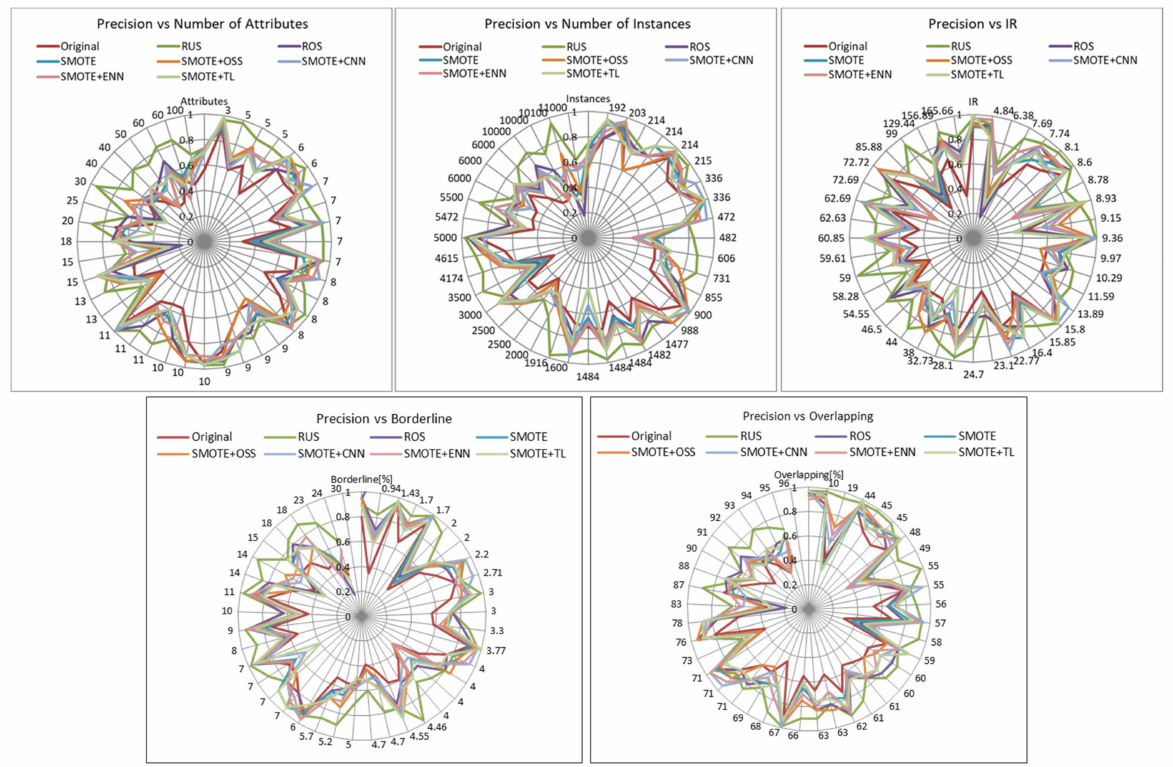
Figure 3. Influence of dataset characteristics on precision for all resampling strategies.